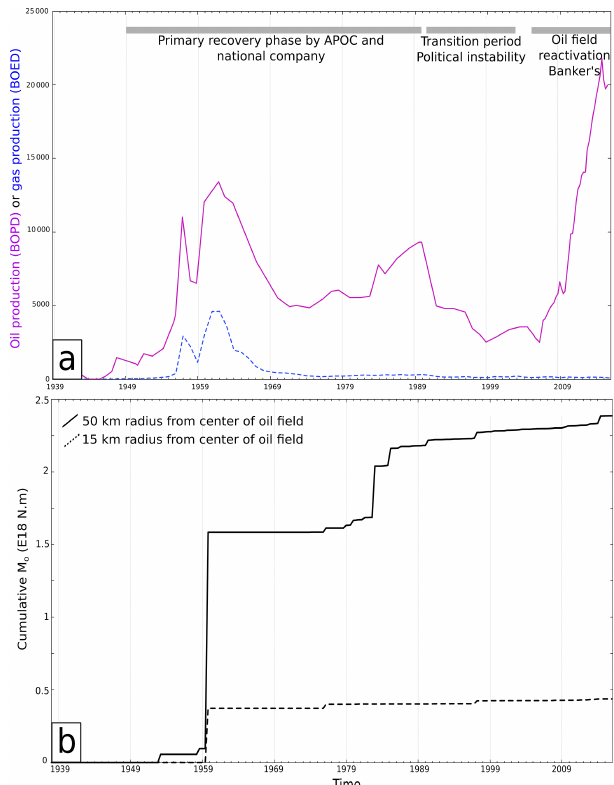
Figure 3. (a) History of production of oil (plain line in barrels of oil per day) and gas (dashed line, in barrels of oil equivalent per day) in the Patos-Marinza field (BCP, 2015; IHS, 2019). (b) Cumulative seismic moment released since 1939 based on a combined USGS- EMSC catalog (USGS, 2019; CSEM-EMSC, 2019, before and after 2004, respectively) over a 50km radius area (plain line) and a 15km radius area around the oil field (dashed line). The contours of these zones are plotted in Fig.